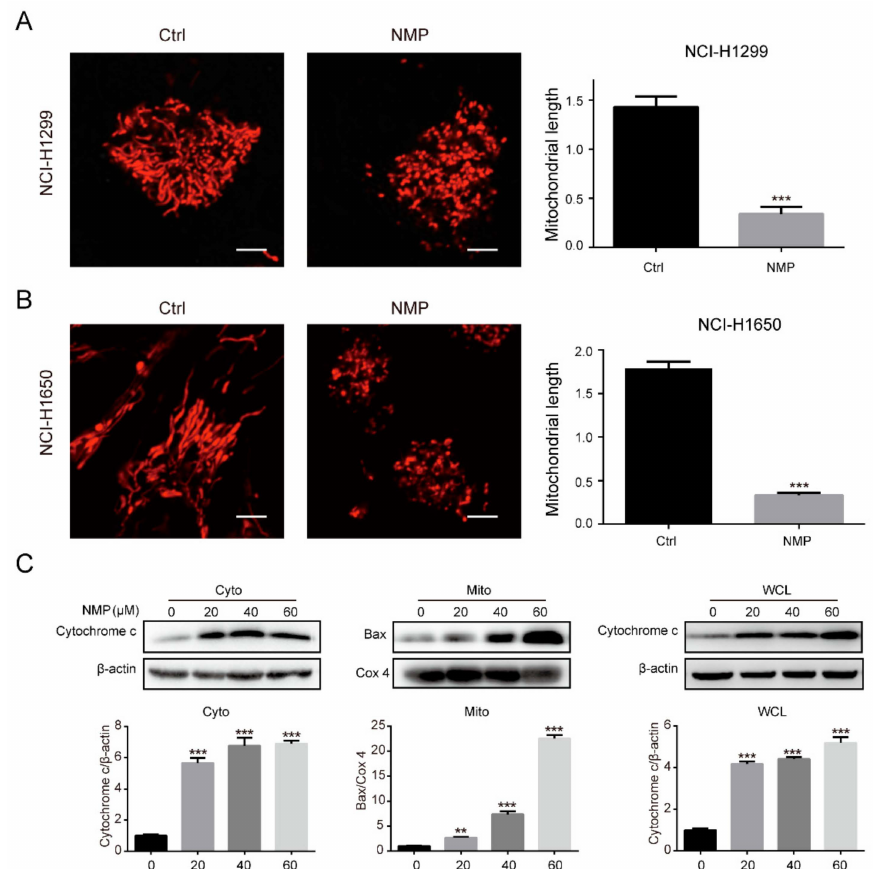
Figure 3. NMP induced apoptosis through a mitochondria-dependent pathway in NSCLC cell lines. ( A , B ) Fluorescence micrographs of mitochondria in a vehicle or 40 µ M NMP-treated NCI-H1299 and NCI-H1650 cells with MitoTracker Red CMXRos staining. The length of mitochondria was quantified with ImageJ (US National Institutes of Health, Bethesda, MD, USA). Scale bar, 5 µ m. Error bars mean ± S.D. of three independent experiments; *** p < 0.001, compared to the control group. ( C ) Western blot assay for mitochondria-dependent apoptosis of di ff erent cellular fractions obtained from NMP treated NCI-H1299 cells. The intensity of bands was quantified by using Gelpro32 Analyzer (Media Cybernetics, Inc., MD, USA). One-way analysis of variance (ANOVA), ** p < 0.01,*** p < 0.001, compared to the control group. Cyto , cytosolic fractions; Mito , mitochondrial fractions; WCL , whole cell